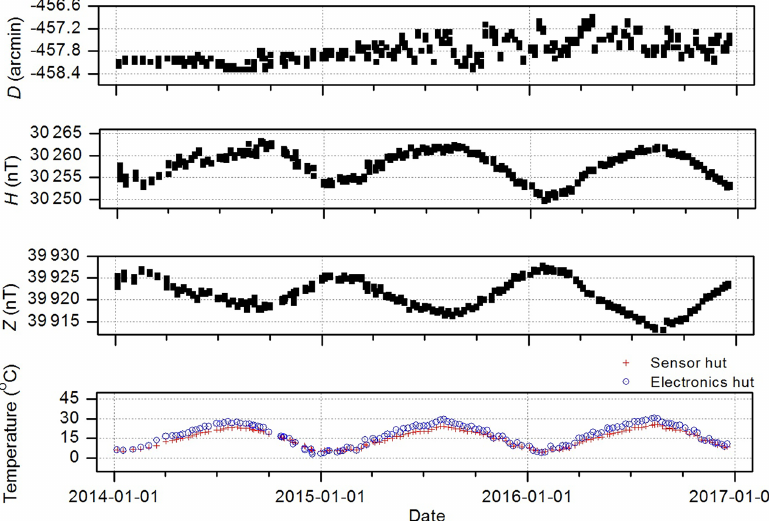
Figure 7. D , H and Z baselines and (lowest panel) temperature of the fluxgate magnetometer sensor and the electronic huts. and the offset of the electronics calculated from the D and the I circle readings according to Eqs. (1) and (2) (Turbitt, 2004): (cid:2) s O D = H sin ( east down + east up − west down − west up )/ 4 (cid:3) , (1) (cid:2) s O I = F sin ( south down + south up − north down − north up )/ 4 (cid:3) . (2)